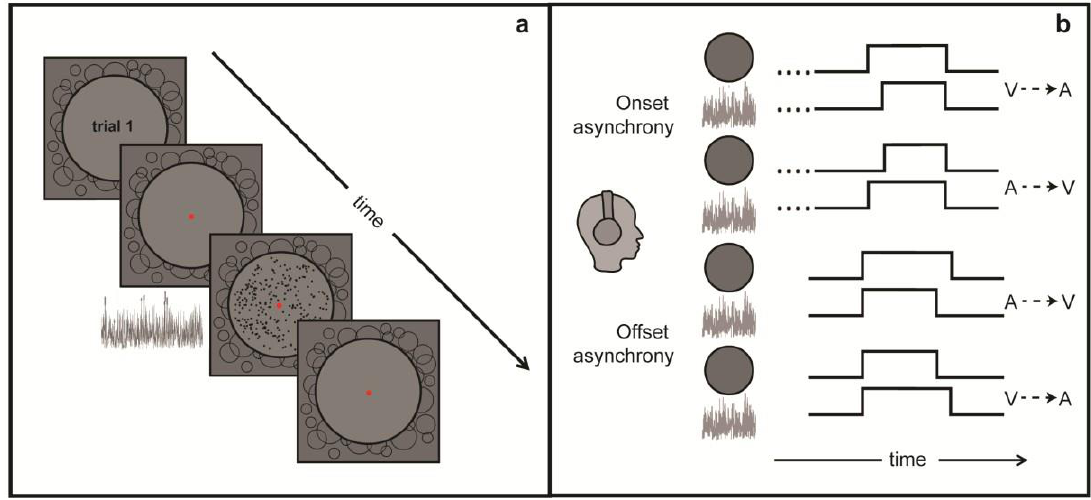
Figure 1. Schematics summarizing stimulus conditions used to assess temporal order judgments (TOJ). ( a ) Sequence of events comprising a given trial; ( b ) plots illustrating asynchronous onsets and asynchronous offsets of visual and auditory events comprising each of the four types of trials. In the actual experiment, onset asynchrony trials and offset asynchrony trials were tested in separate blocks, with stimulus asynchrony (SOA) varied according to a staircase procedure. After each presentation of a pair of stimuli, the participant judged which event occurred first, auditory or visual, where the designated event was either stimulus onset or stimulus offset (administered in separate trial blocks).